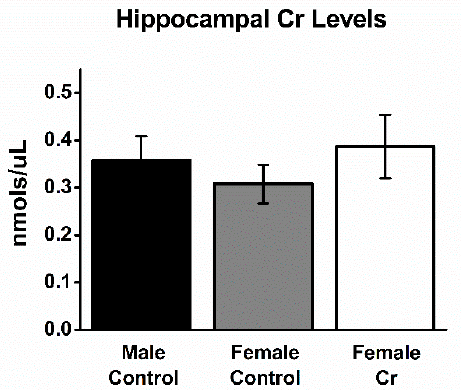
Figure 6. Levels of Cr in the hippocampus after 8 weeks of dietary intervention. Levels of Cr were measured in the hippocampi of Cr-supplemented female and control-fed male and female mice from tissue homogenates using a colorimetric kit (BioVision Inc.). ANOVA: female control: n = 3; female Cr: n = 5; male control: n = 3; p > 0.05.